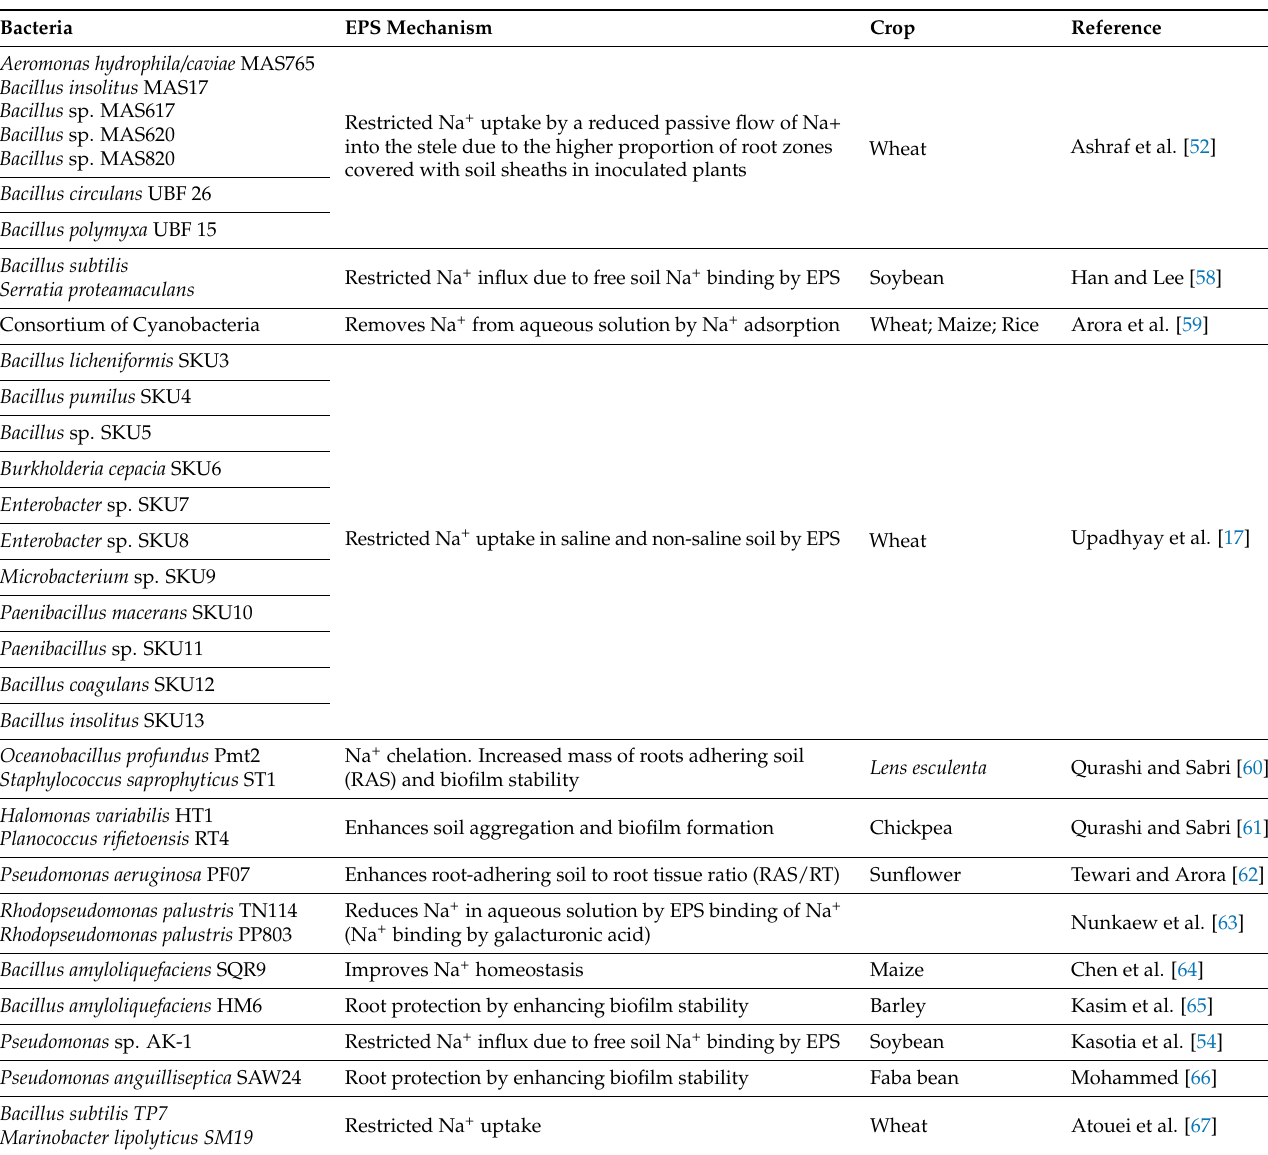
Table 1. PGPR’s mechanisms to alleviate salinity stress in